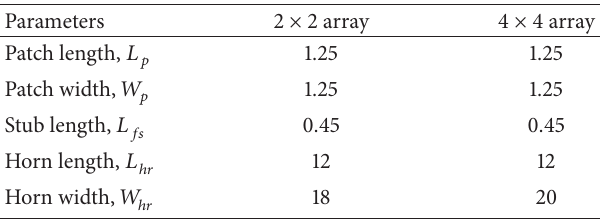
Table 3: Modified antenna parameters.